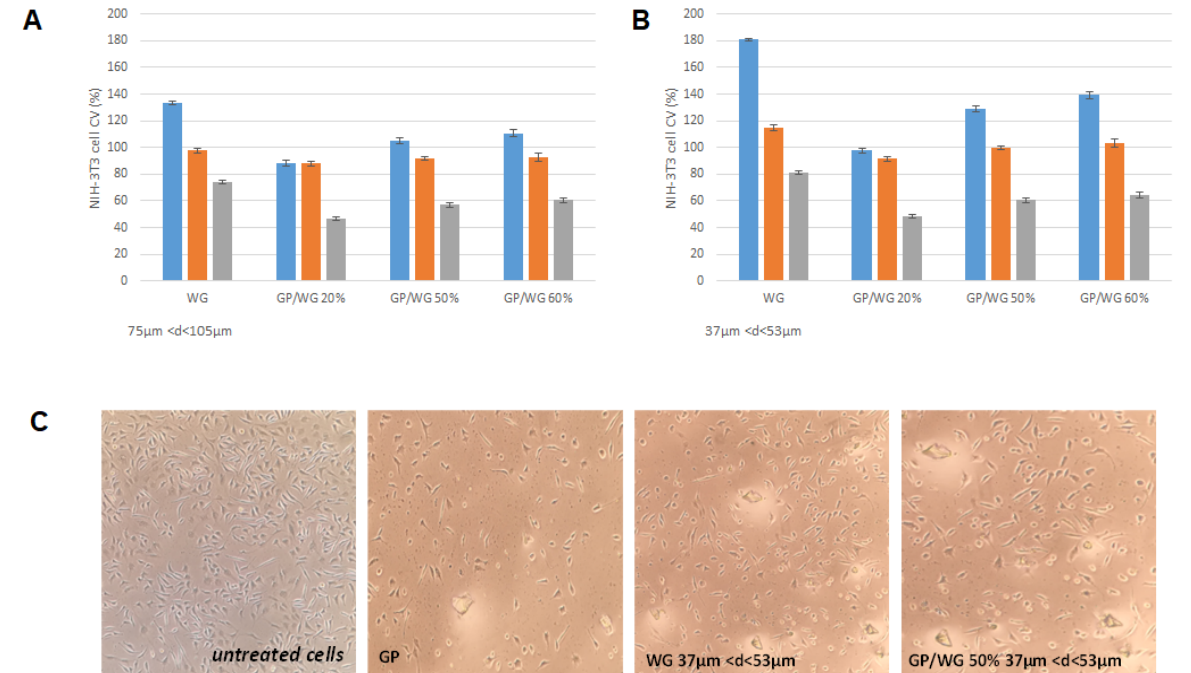
Figure 8. NIH-3T3 cell viability (CV, %) assessed by means of MTT assay at 2 (blue), 6 (red), and 48 (grey) hours of exposure time. ( A ) Data acquired by treating cells with 75–105 µ m and GP/WG 37–53 µ m (values are the mean ± SD of three independent experiments); ( B ) data acquired by treating cells with WG 37–53 µ m and GP/WG 37–53 µ m (values are the mean ± SD of three independent experiments). ( C ) Representative images of NIH-3T3 cells grown in absence (untreated cells) or in presence of GP, WG, 37–53 µ m, and GP/WG 50%. 37–53 µ m. The images were acquired after 6 h exposure time.